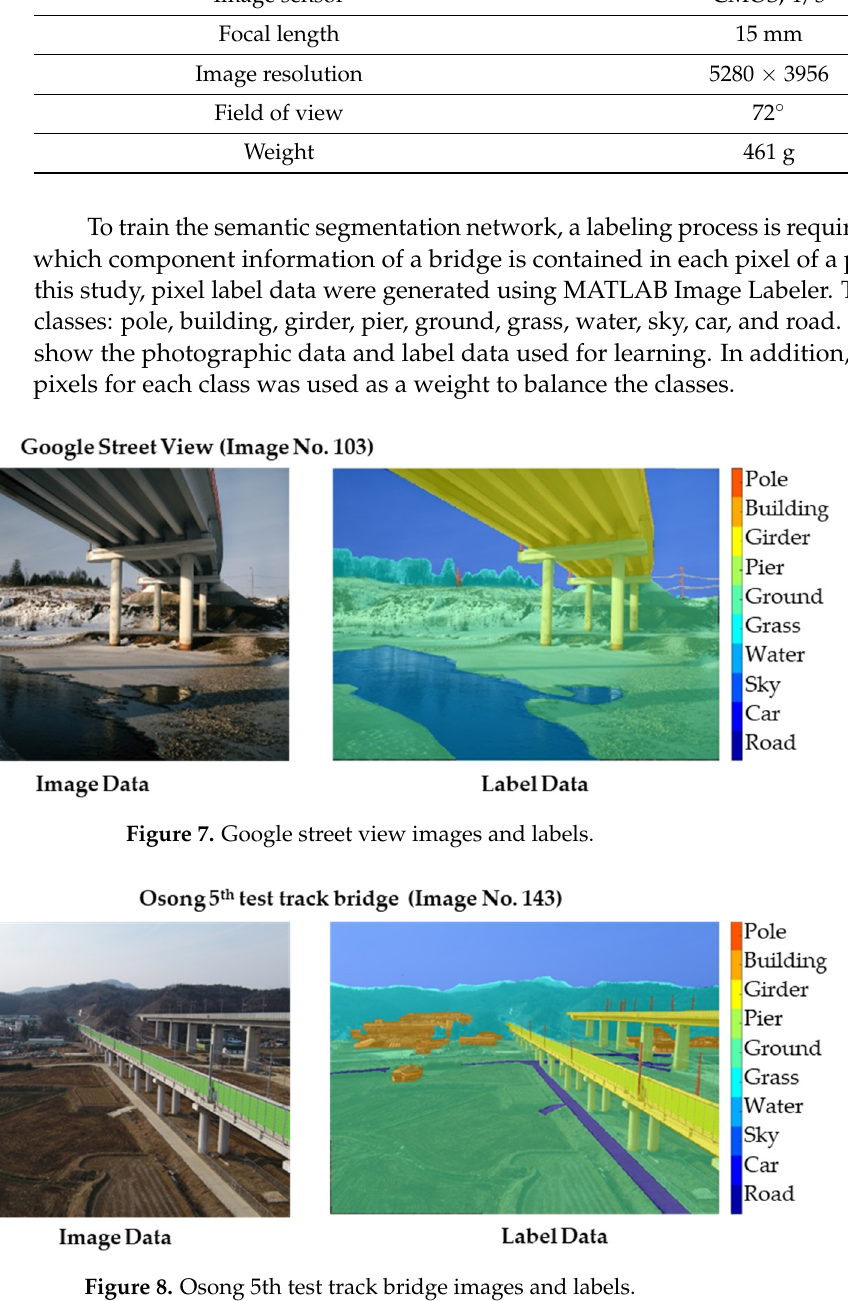
Figure 8. Osong 5th test track bridge images and labels.